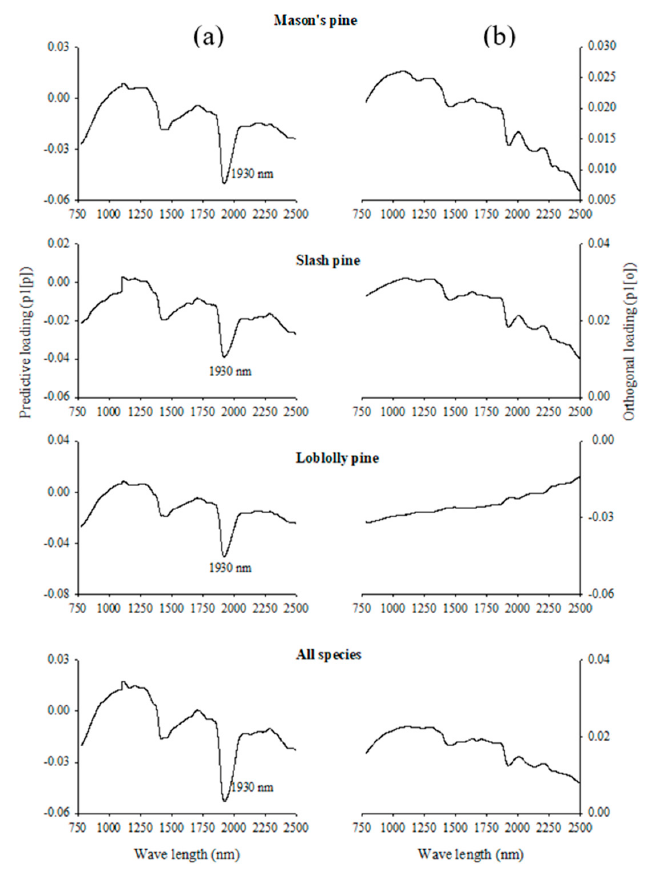
Figure 3. Loading plots for the predictive component (P1[p]; ( a )) and the first orthogonal component (P1[o]; ( b )) showing absorption bands correlating to seed classes and those that are not correlated to class discrimination, respectively.